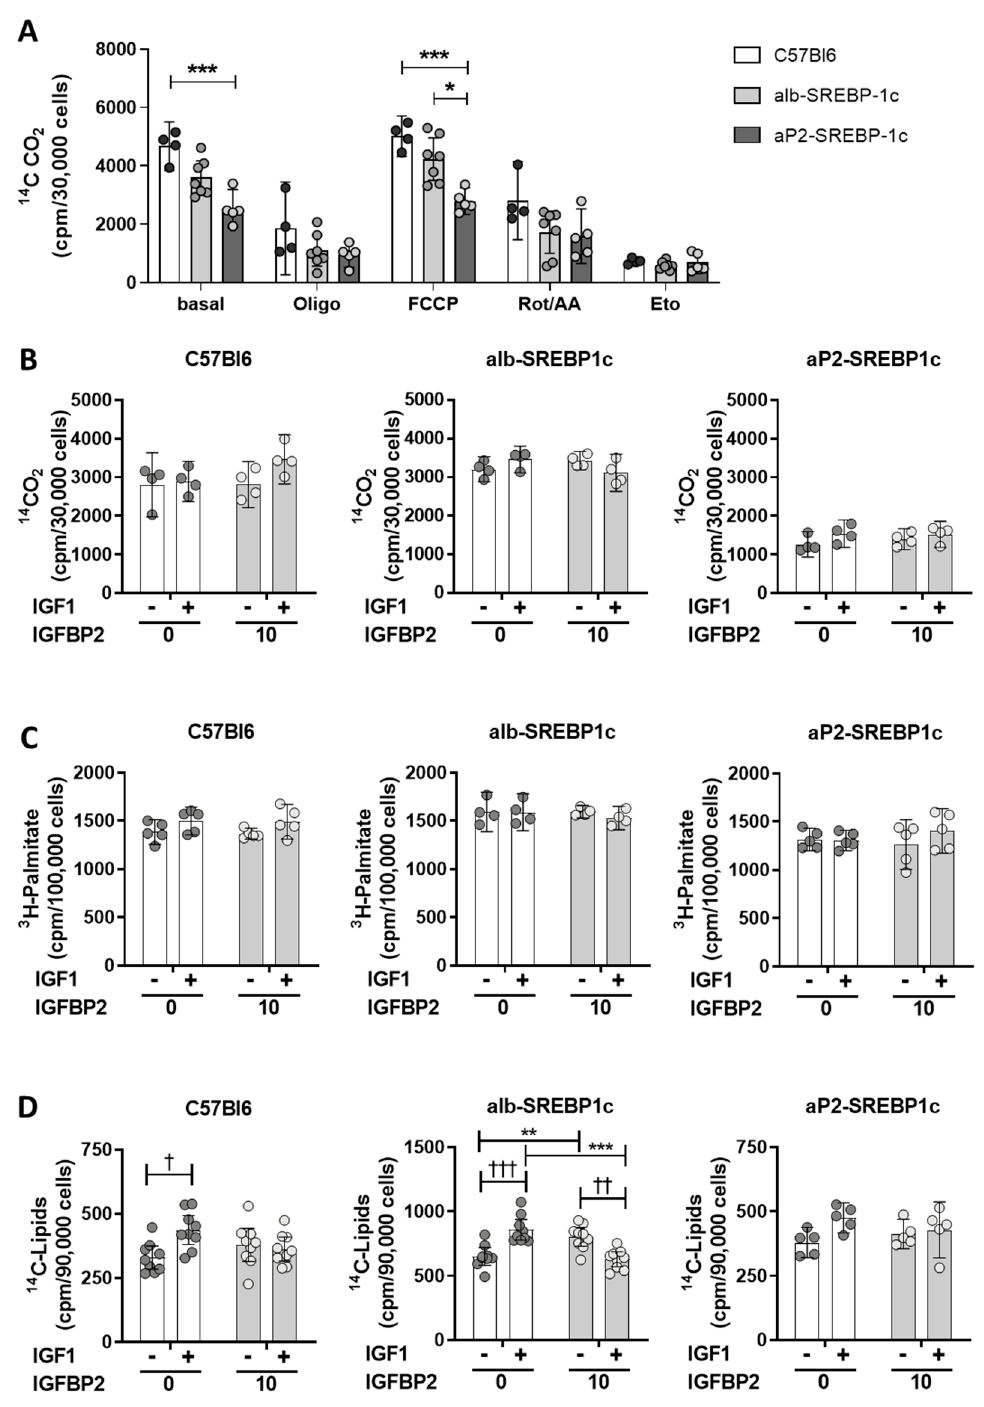
Figure 5. Oxidative capacity and effects of IGF1 and IGFBP2 on lipid metabolism in hepatocytes. ( A ) Hepatocytes from C57Bl6 (C57), alb-SREBP-1c (alb), and aP2-SREBP-1c (aP2) mice were analyzed for palmitate oxidation in untreated cells or under inhibitors of mitochondrial activity (Oligomycin (Oligo), Carbonyl cyanide 4-(trifluoromethoxy)phenylhydrazone (FCCP), Rotenone/Antimycin A (Rot/AA) and Etomoxir (Eto)) ( B ) palmitate oxidation, ( C ) palmitate uptake, and ( D ) de novo lipogenesis under basal conditions and in response to IGF1, IGFBP2, and IGF1 pre-bound to IGFBP2. The bar graphs represent mean (±95% CI; n = 4–9). Statistics: ANOVA with Sidak correction: †††, ††, and † indicate p < 0.001, p < 0.01 and p < 0.05 for the effects of IGF1; *** p < 0.001, ** p < 0.01 and * p < 0.05for the illustrated comparisons. Cpm: counts per minute.